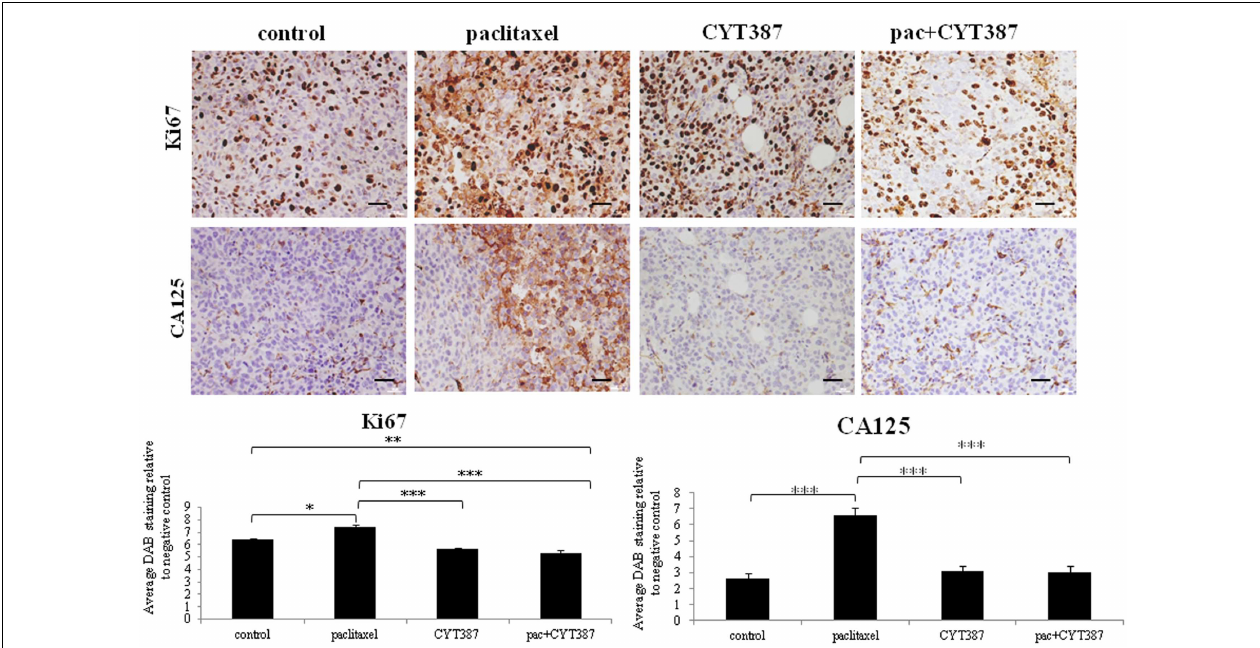
Magnification 200 × , scale bar = 10 µ M. Average DAB intensity and proportion of staining of Ki67 or CA125 in xenografts was standardized to negative control.The experiments were performed using five independent samples in each group. Significant intergroup variations are indicted by * p < 0.05, ** p < 0.01, and *** p <